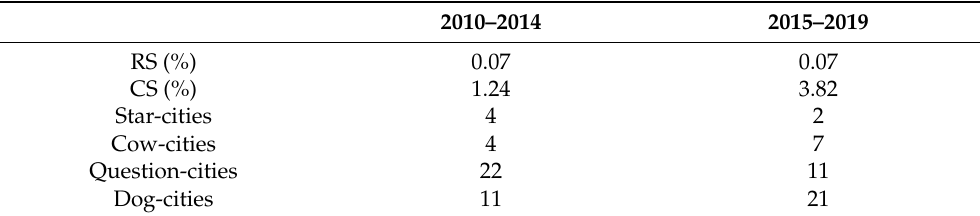
Figure 9. Spatial analysis of the evolution mode in 2015–2019. Table 4. Analysis of the spatial heterogeneity parameters of urban industrial land in Yangtze River